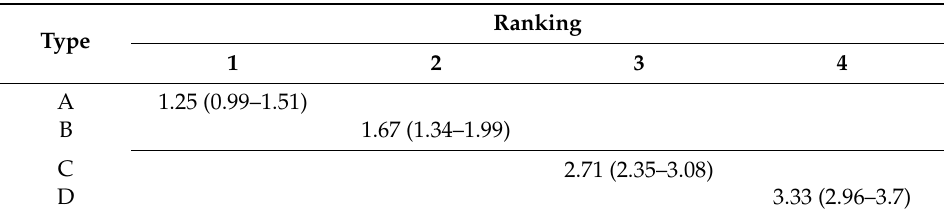
Table 3. Evaluation ranking of safety levels of different types of scaffolding.